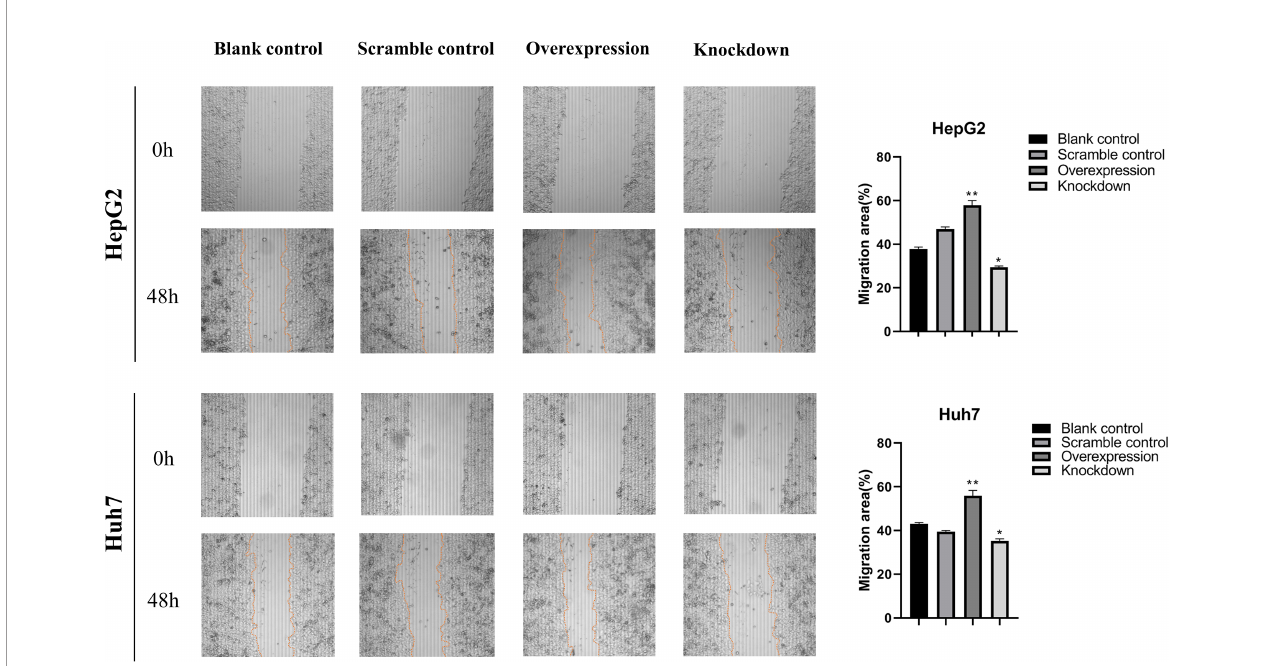
FIGURE 5 | Scratch wound healing assays revealed effects of ASAP1-IT1 on cell migration in HepG2 and Huh7 cells. Scratch wound healing assays showed that knockdown of ASAP1-IT1 reduced the migration ability, while overexpression of ASAP1-IT1 promoted migration in HepG2 and Huh7 cells. The wound edge at 0 h, Scale bar, 200 m m. The distance migrated by the cells at the leading edge was quantitated and plotted at 48 h. The data were expressed as the means ± standard deviation (SD) from three independent experiments. * p < 0.05, ** p < 0.01 vs control groups.